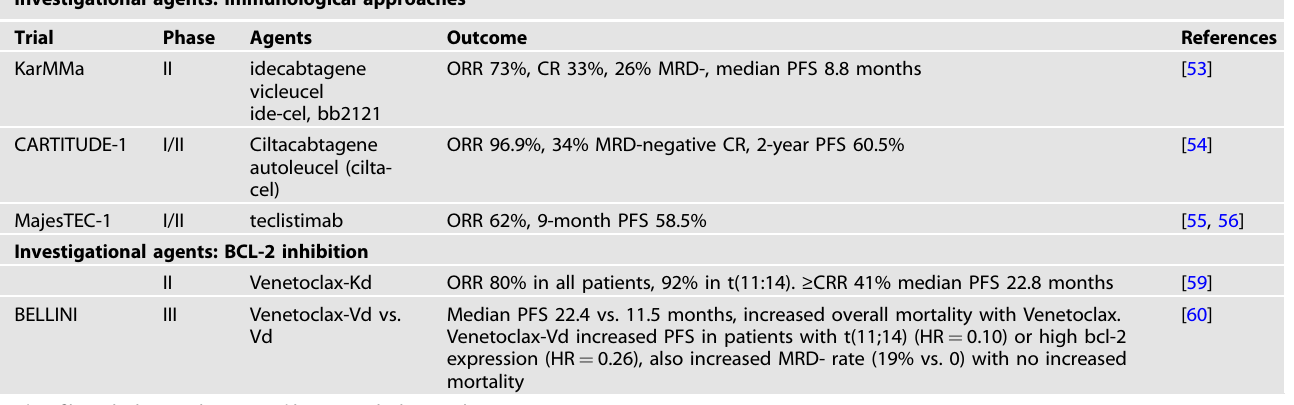
Table 4. Trials of investigational agents in relapsed/refractory